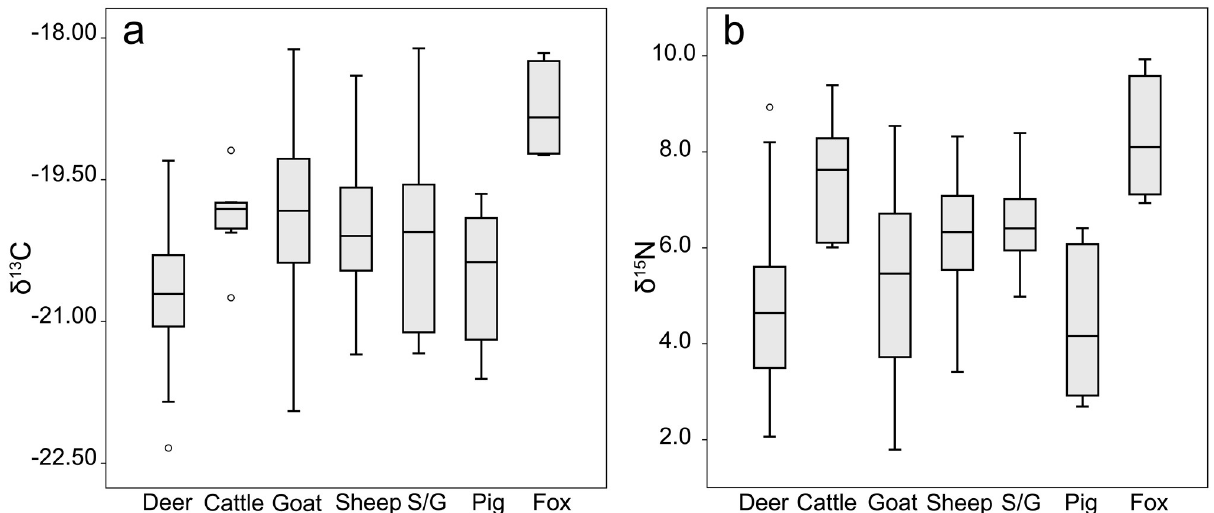
Bone collagen: δ 13 C. Mean values of δ 13 C for the fauna from Politiko- Troullia , which